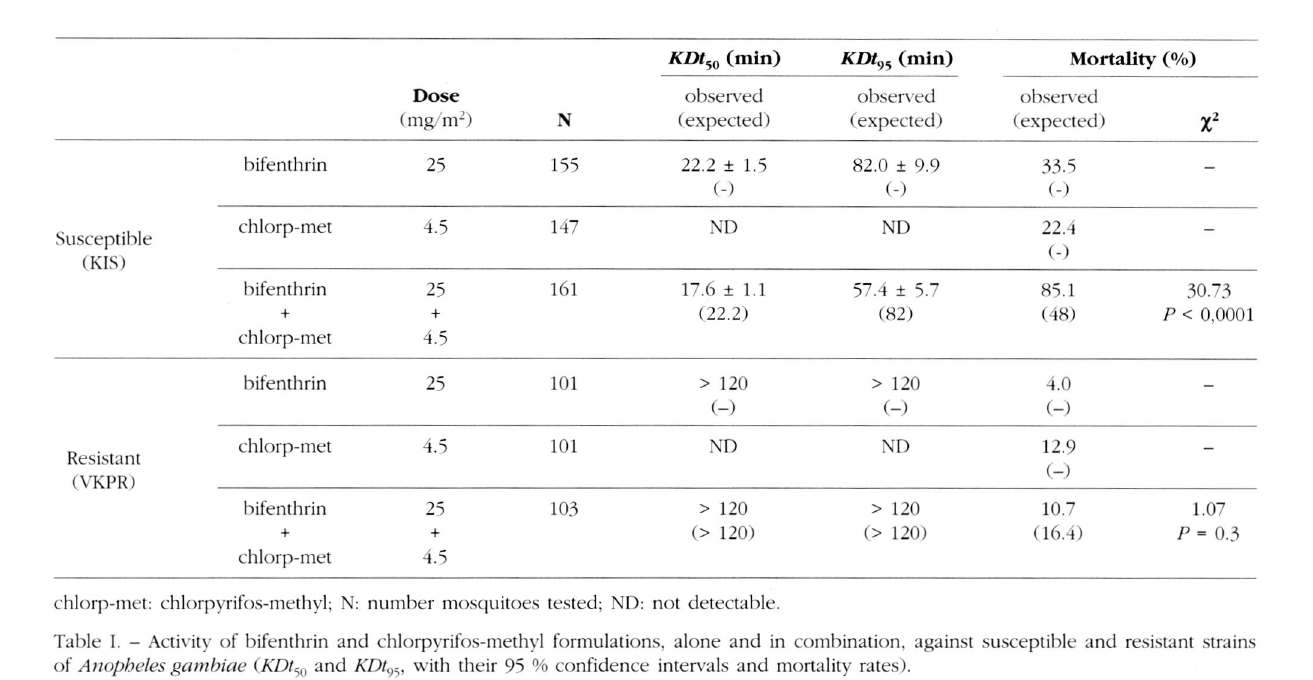
EFFICACY OF BIFENTHRIN/CHLORPYRIFOS-METHYL